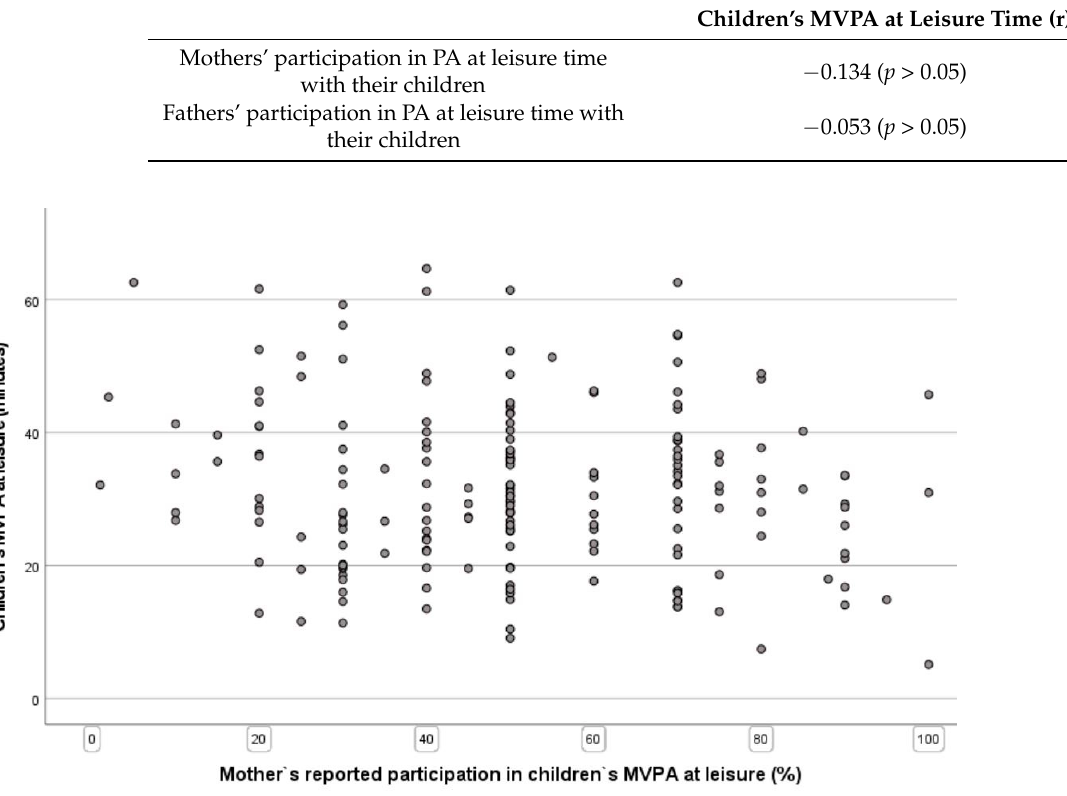
Figure 3. Scatter plot of preschool children’s MVPA at leisure time and mothers’ reported participation in MVPA with their children.